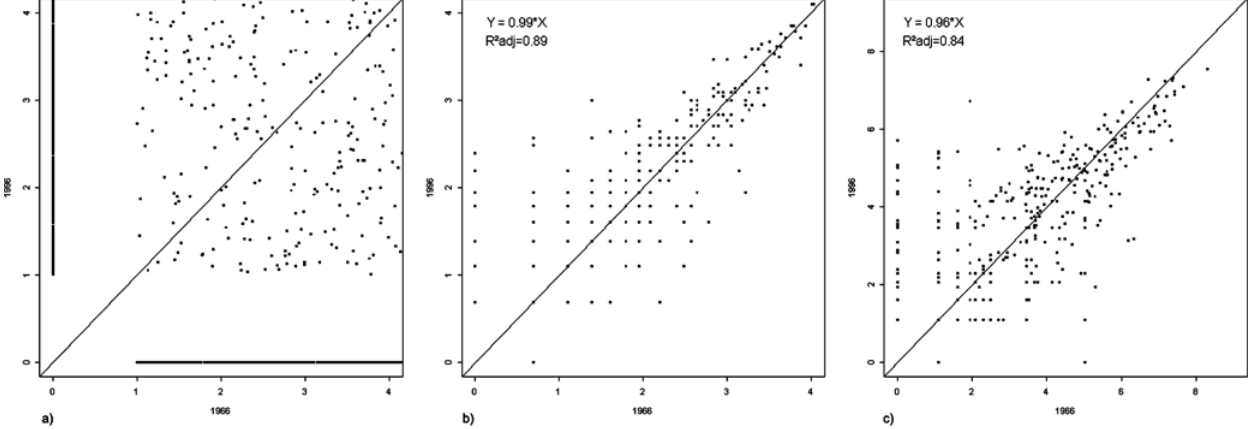
Figure 4. (a) Relationship between the local species abundance (populations of each species within each plot at the time considered) in 1966 and 1996. Data shown are for one set of estimated actual abundances, a range of r 2 values for 100 estimates are reported [ r 2 =0.037–0.058, p , 0.001]. (b) Relationship between the meta-community spread (number of plots where a species is present) in 1966 and in 1996. (c) Relationship between the meta-community species abundance (total number of individuals for each species across all sites) in 1966 and 1996; The plots b and c are shown on a logarithmic scale.